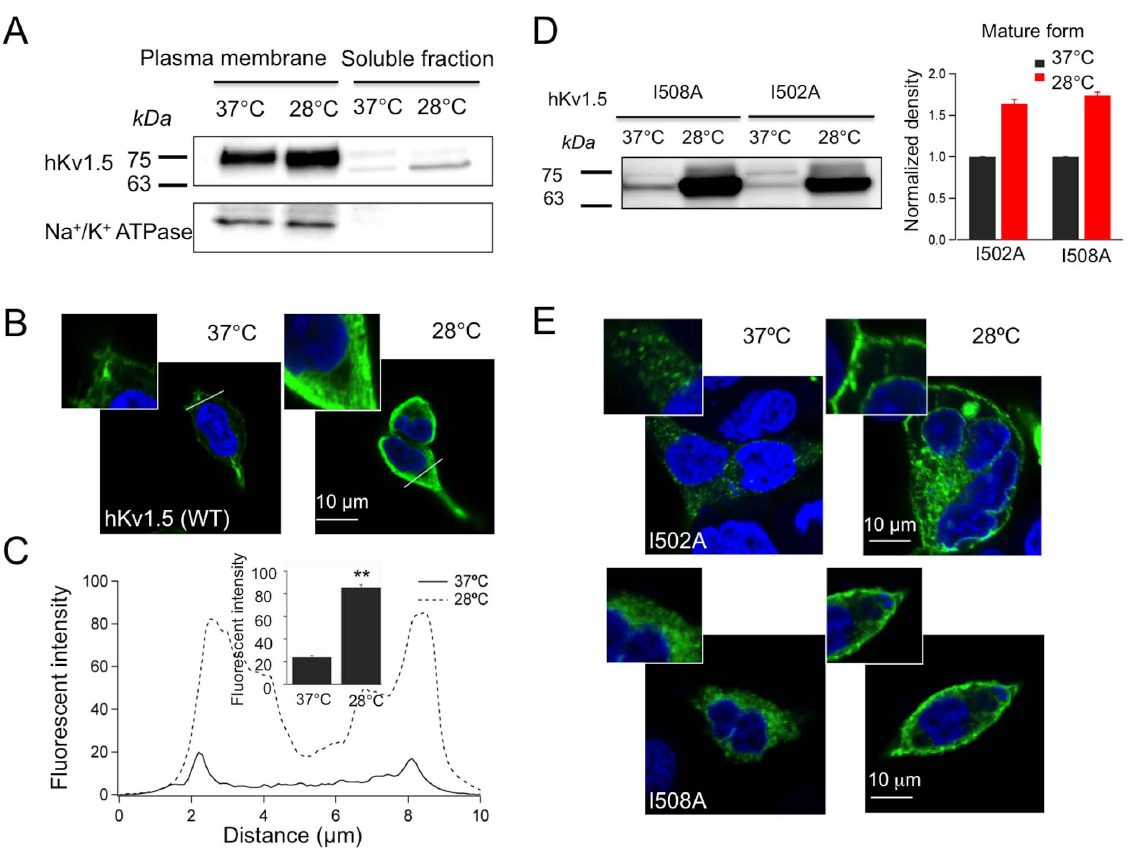
Figure 5. The accumulation of hKv1.5 in the plasma membrane is promoted by low- temperature cultivation. (A) Western blot analysis of the plasma membrane and soluble fractions of the hKv1.5 protein isolated from the HEK-hKv1.5s cells cultured at 37 u C or 28 u C; Na + /K + ATPase beta-1 was used as a plasma membrane marker. (B) Confocal images of the HEK-hKv1.5s cells cultured at 37 u C or 28 u C. (C) A representative linear plot analysis of the hKv1.5 fluorescent intensity. The x-axis indicates the length across the cell area and the y-axis indicates the fluorescence intensity. The summarized fluorescence intensities measured within the peak of the fluorescent intensity (inset). (D) Western blot analysis for the hKv1.5 mutants (I508A, I502A), transiently expressed in CHO cells, under two temperature conditions (37 u C and 28 u C). (E) Confocal images of the HEK cells transiently expressing hKv1.5 I502A and I508A, cultured at 37 u C or 28 u C (** P , 0.01 vs 37 u C culture).